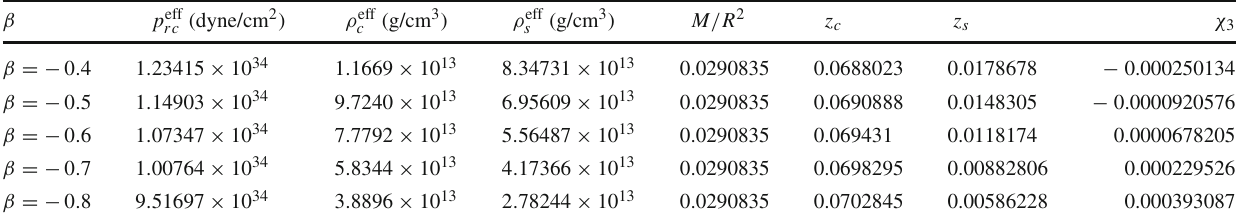
Table 2 Numerical values of physical parameters of the MGD solution for C = 0 . 0021km − 2 , D = 0 . 0015 km − 2 , R = 11 km, χ 1 = 0 . 2 and χ = 1 / 3 with different decoupling constant β for fix coupling parameter α = 5 km 2